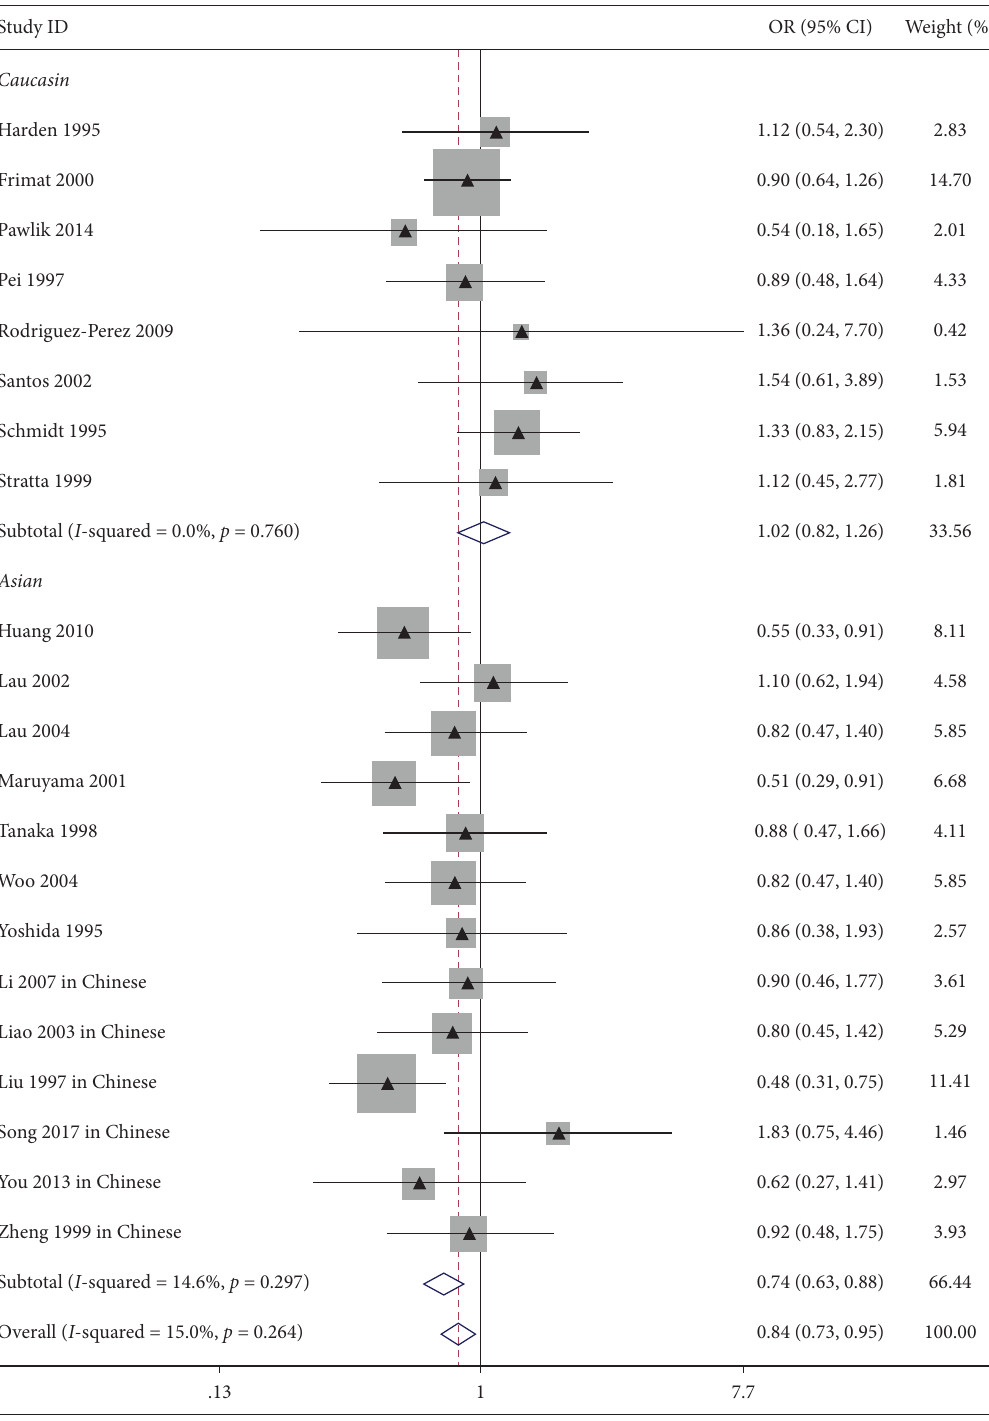
Figure 3: Forest plot about the link between ACE I/ D gene polymorphism and IgAN risk (II genotype vs. DD +ID genotype). Evaluates of pooled OR for IgAN showed that the ACE gene locus II genotype was a protective factor of IgAN in the overall and Asian